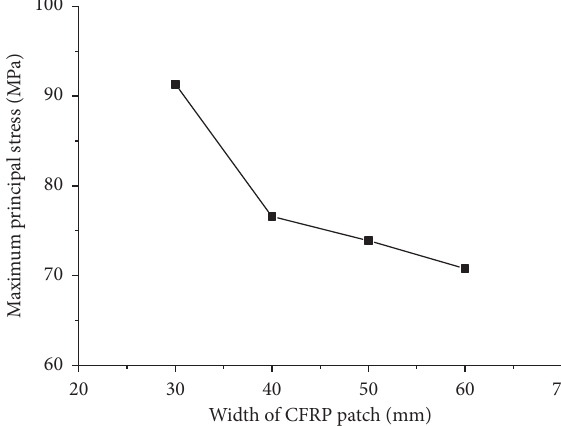
Figure 7: The principal stress of steel plate under various preloads.